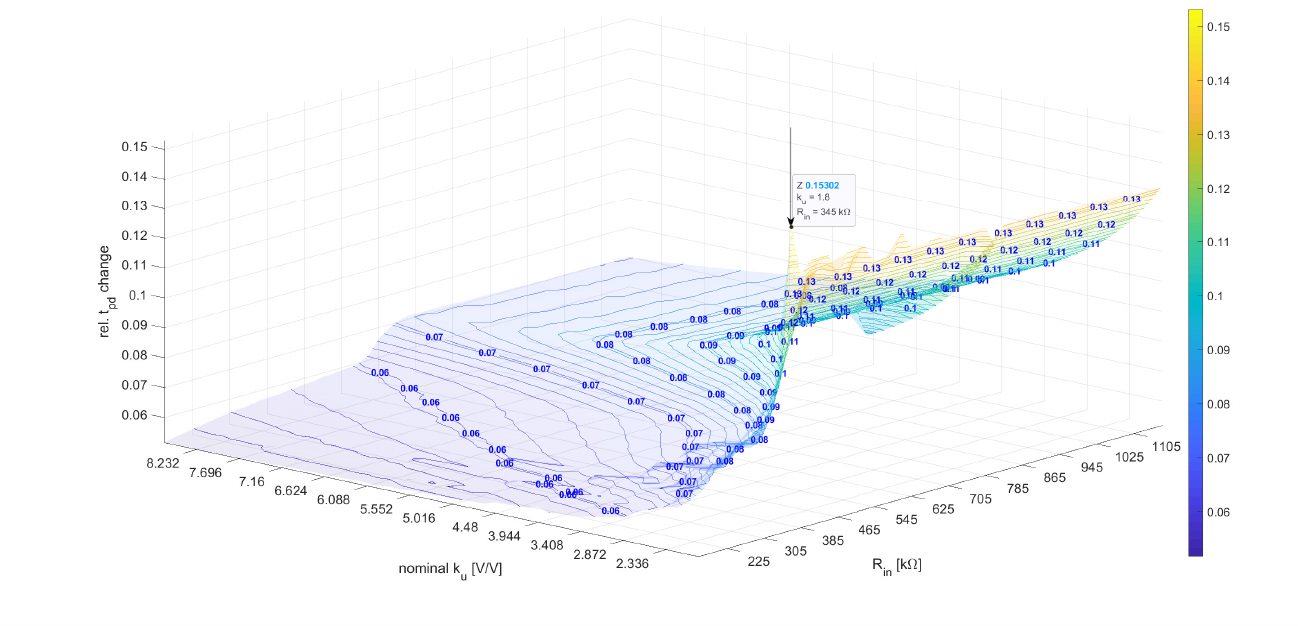
Figure 11. The relative t pd influence for various k u and R in for a linear